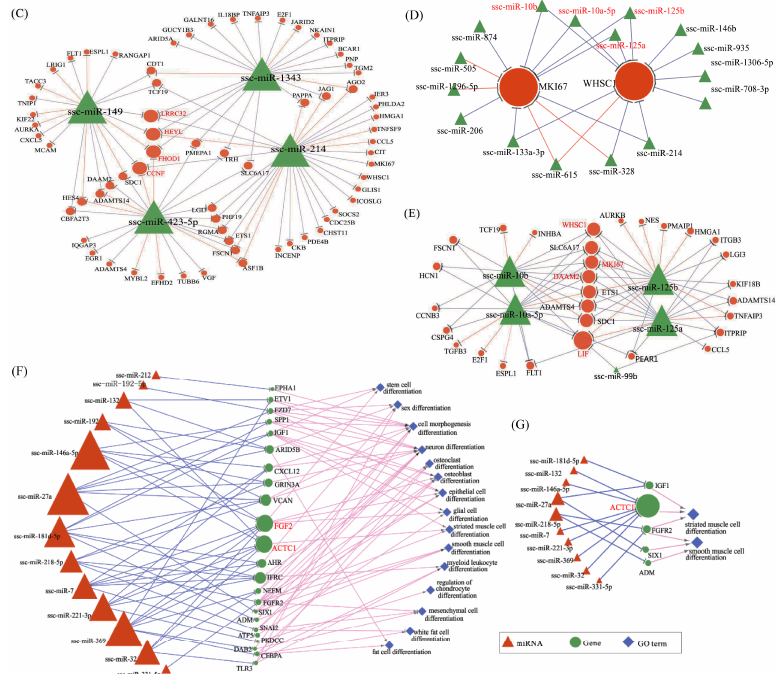
Figure 5. Analyses of mRNA-miRNA networks in P-N1ICD vs. P-Control. ( A ) The network of upregulated miRNAs and downregulated genes in P-N1ICD vs. P-Control. Deep orange triangle represents upregulated miRNA; green circle represents downregulated gene; blue lines represent predicted targeting genes; orange lines represent verification of targeting genes. ( B ) The network of downregulated miRNAs and upregulated genes in proliferation. Green triangle represents downregulated miRNA; deep orange circle represents upregulated gene. ( C ) The network of four hub downregulated miRNAs (ssc-miR-214, ssc-miR-423-5p, ssc-miR-149 and ssc-miR-1343) in P-N1ICD vs. P-Control, the hub genes of which are leucine rich repeat containing 32 (LRRC32), hes related family bHLH transcription factor with YRPW motif-like (HEYL), formin homology 2 domain containing 1 (FHOD1) and cyclin F (CCNF). ( D ) The network of two hub upregulated genes (MKI67 and WHSC1). Both MKI67 and WHSC1 are targeted by ssc-miR-10b, ssc-miR-10a-5p, ssc-miR-125a and ssc-miR-125b, which belong to the miR-10 family. ( E ) The network of five downregulated miRNAs in proliferation, which belong to the miR-10 family. Interleukin 6 family cytokine (LIF) is targeted by all five miRNAs. Three hub genes in the Figure 4B network, including MKI67, WHSC1 and dishevelled associated activator of morphogenesis 2 (DAAM2), are targeted by ssc-miR-10b, ssc-miR-10a-5p, ssc-miR-125a and ssc-miR-125b. ( F ) The network of downregulated miRNAs, upregulated genes and differentiation-related GO terms. Blue rhombus represents differentiation-related GO terms. ( G ) The network of downregulated miRNAs, upregulated genes and muscle cell differentiation-related GO terms. Blue rhombus represents differentiation-related GO